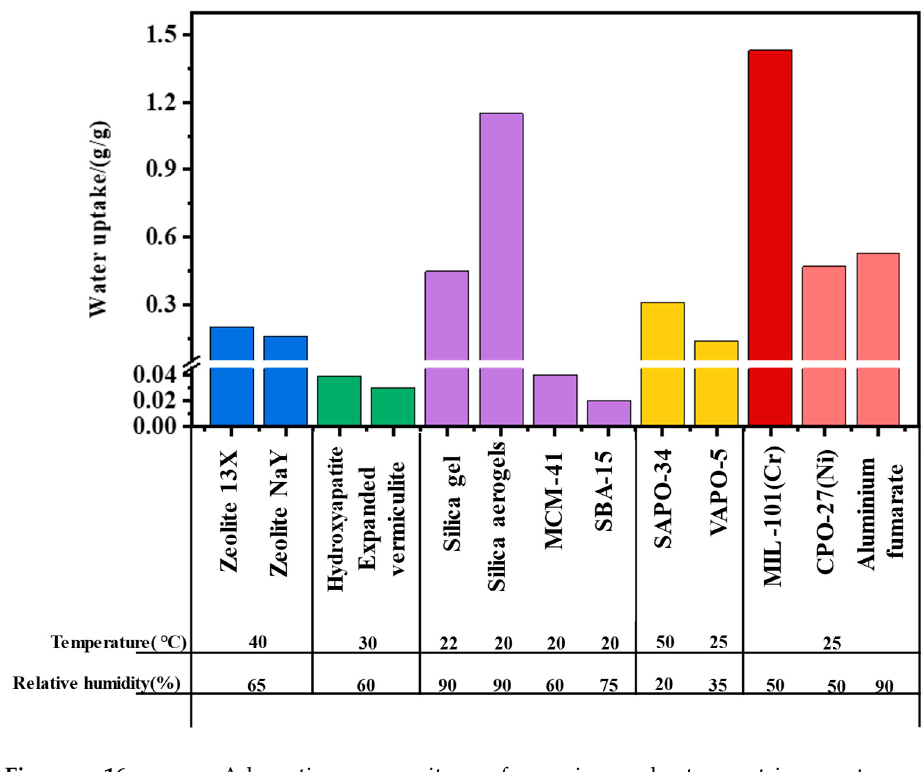
Figure 16. Adsorption capacity of various host matrices at speci fi ed conditions [60,110,124,134,150,151,170,181,182].